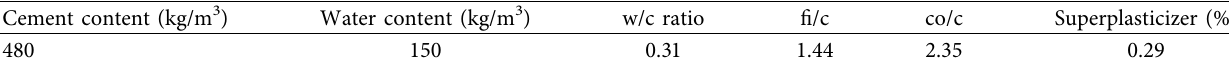
Table 1: Concrete mix